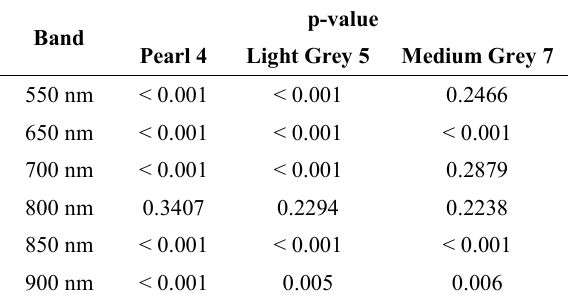
Table 5. The results of Mann-Whitney U test. The null hypothesis was: Resulting reflectance values of three validation targets extracted from the laboratory calibrated and in-situ calibrated image are from the same distribution The resulting NRMSE values are comparable with the results of previous works of Pozo et al. (2014) (2%), Aasen et al. (2014) (1%) and Yang et al. (2017) (5%) focused on calibration of hyperspectral sensors. In general, Richter and Schläpfer